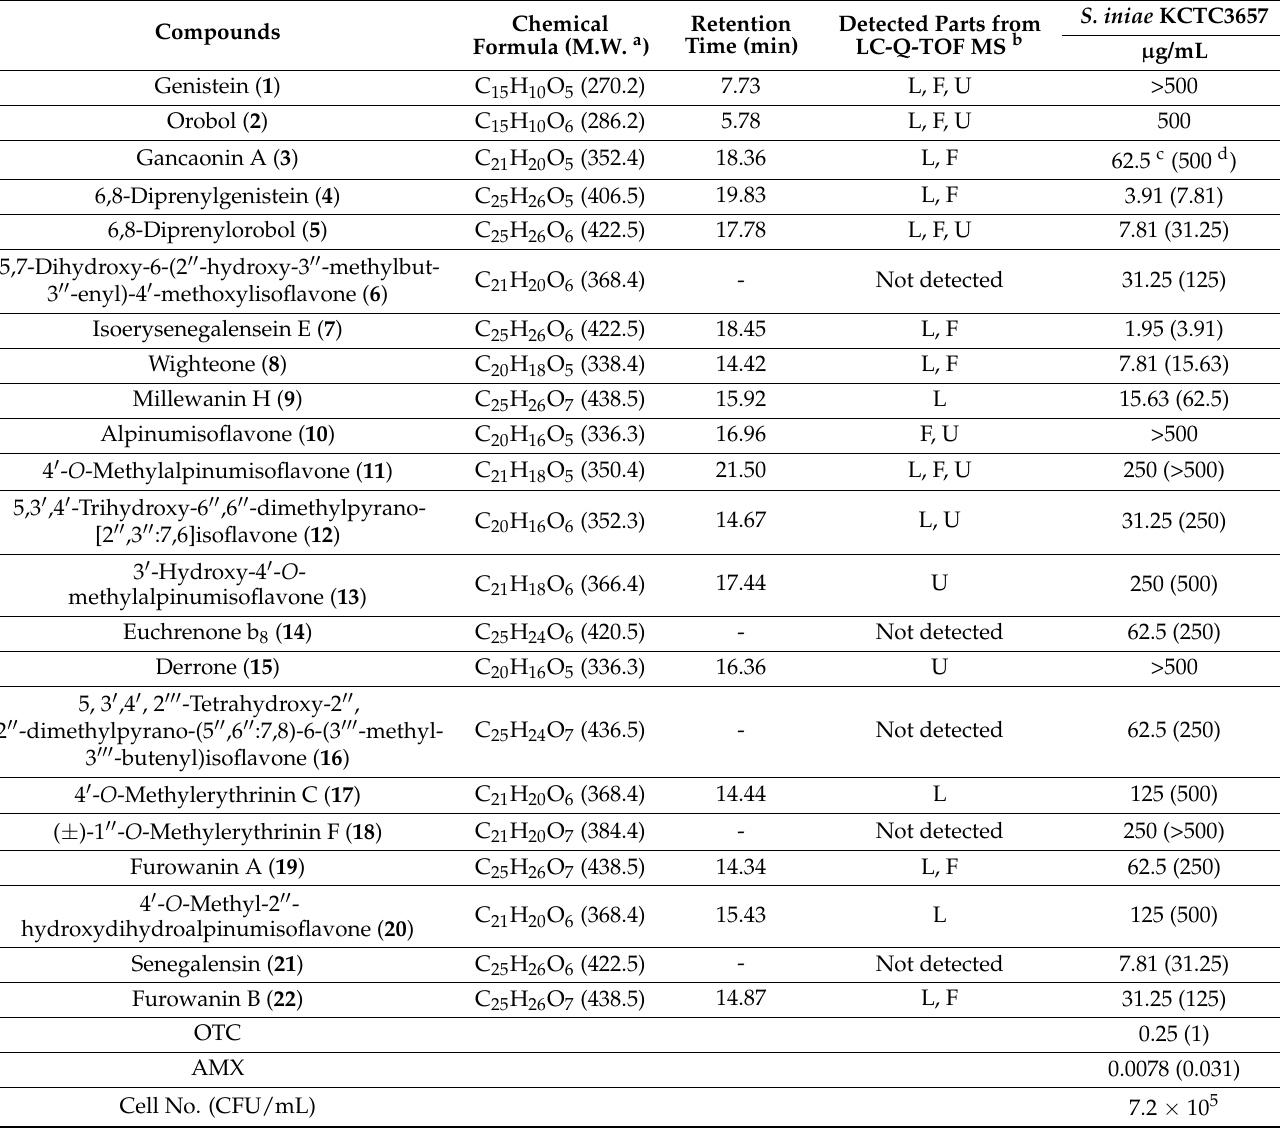
Table 1. Antibacterial activities against S. iniae of 22 isoflavones from M. tricuspidata . Compounds Chemical Formula (M.W. a